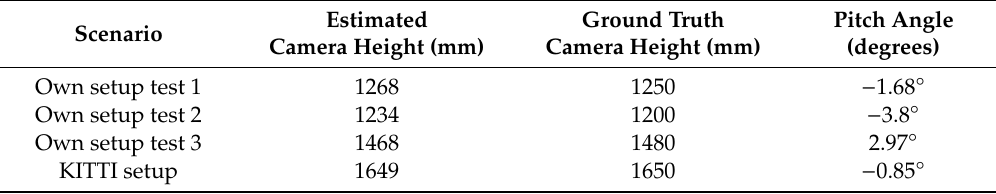
Table 2. Self-calibration results for camera height and pitch angle